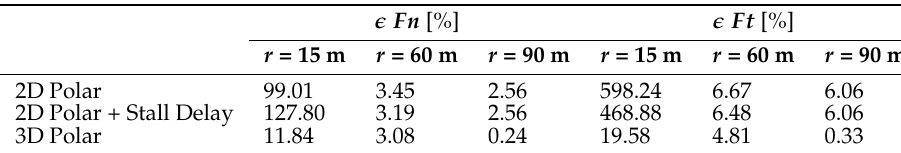
Table 3. Error quantification of the sectional loads with respect to the 3D CFD data.